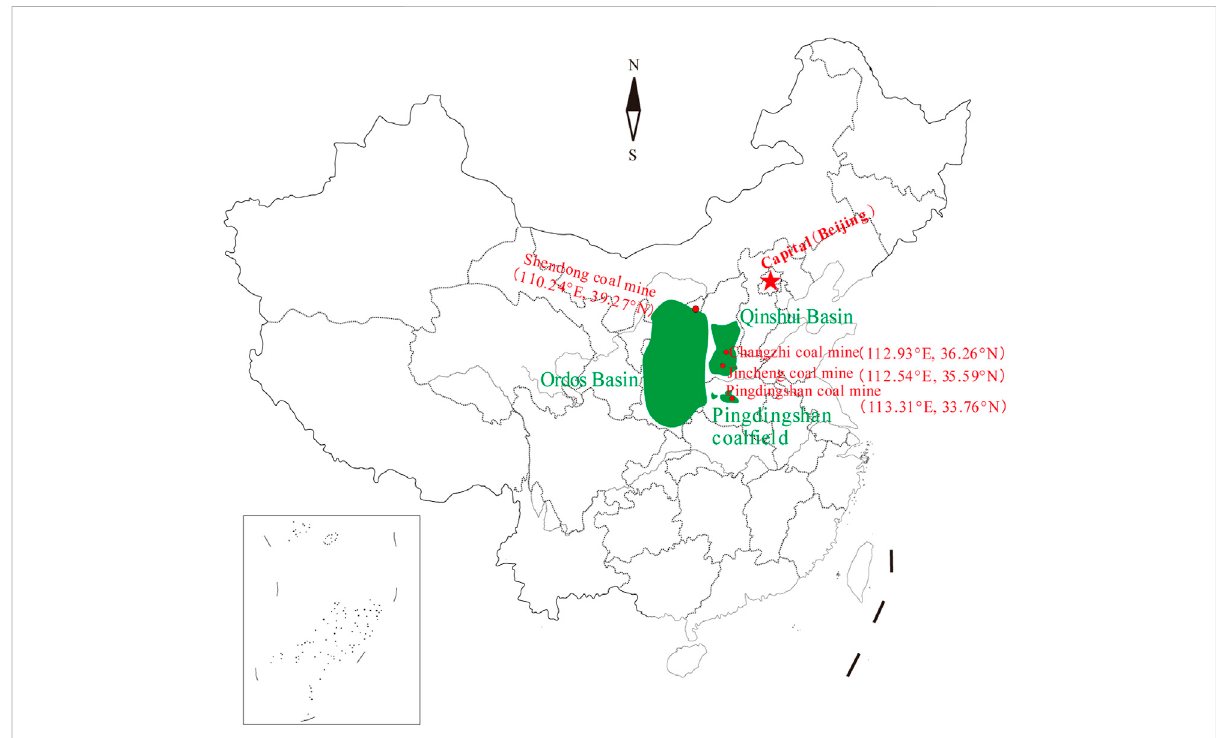
FIGURE 1 Location of sampled